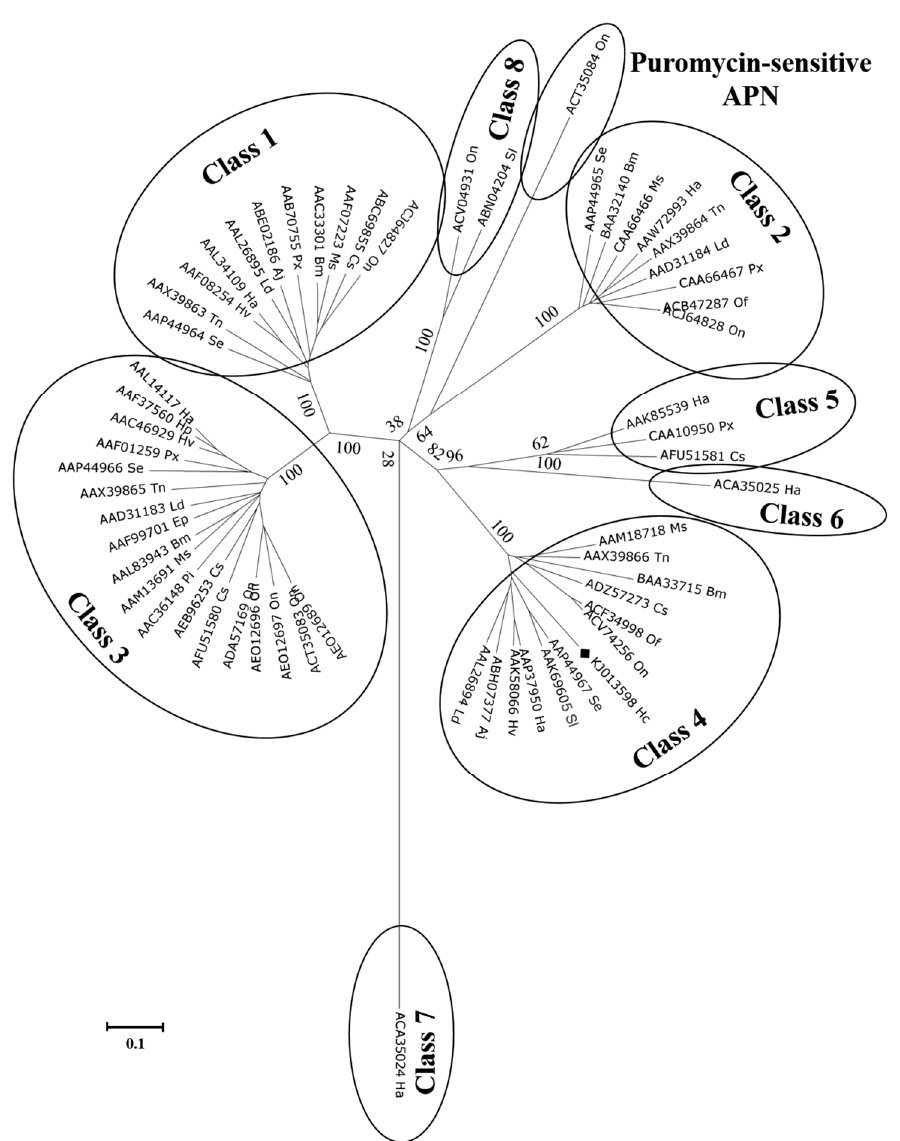
Figure 4. Phylogenetic tree derived from Clustal X alignment of complete lepidopteran APN protein sequences deposited in GenBank. Bootstrap values, expressed as percentages of 1000 replicates, are indicated for the principal nodes. The accession number of each amino acid sequence are indicated.